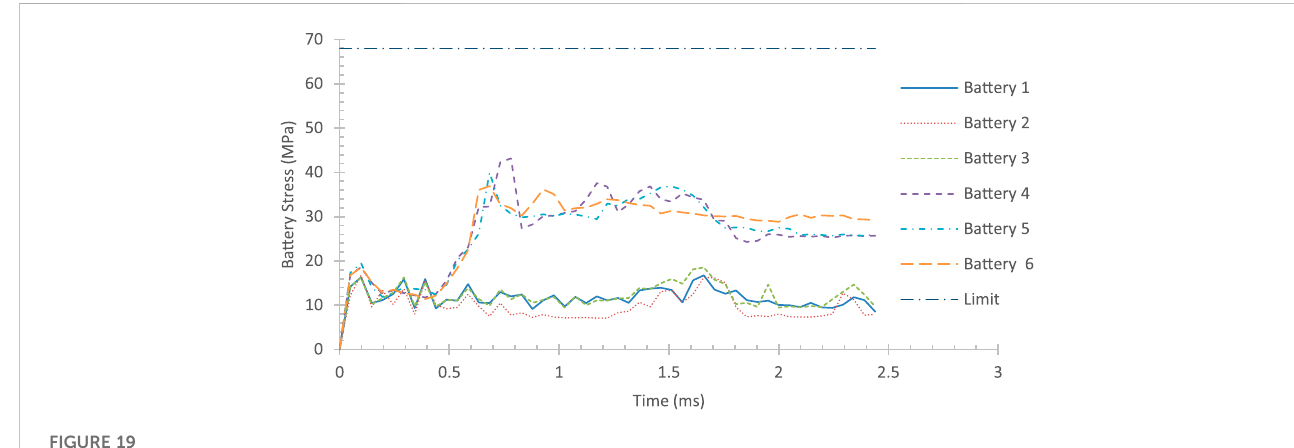
FIGURE 19 Battery ’ s von Mises Stress vs. time of system with optimum design.